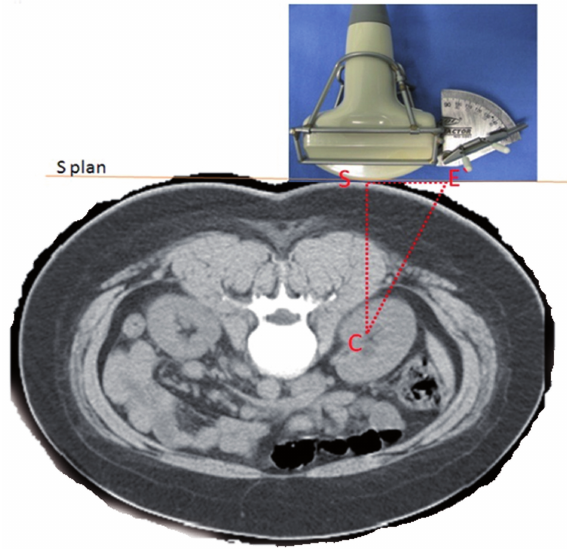
Figure 1 - Vertices of the initial right triangle: the target calyx (C); the “apex” of ultrasound transducer in contact with the skin, perpendicular to the aimed calyx (S); and the orthogonal projection of the center of the protractor in the skin plane